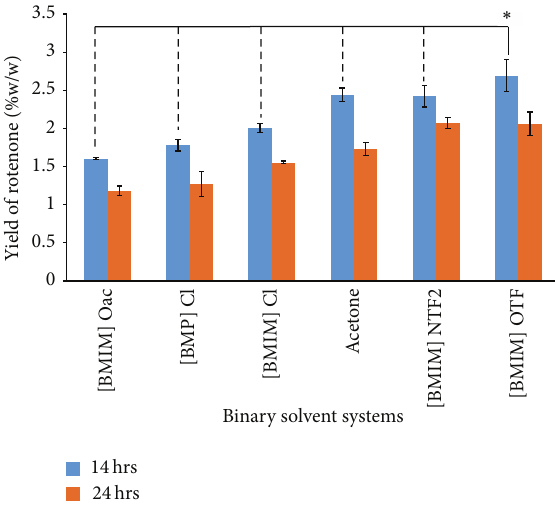
Figure 4: Concentration of rotenone (mg/mL) with respect to five different types of binary solvent systems. Ψ 𝑃 < 0.05 —[BMIMI] OTF + acetone is the best binary solvent system to procure the highest rotenone concentration (mg/mL) at the optimum time of extraction process (14hrs). ∗ 𝑃 < 0.05 —[BMIMI] NTF2 + acetone and acetone extract produced high concentration as compared to the [BMIM] Oac, [BMP] Cl, and [BMIM] Cl. Error bars represent the standard deviation (SD) of triplicates ( 𝑛 = 3 ).